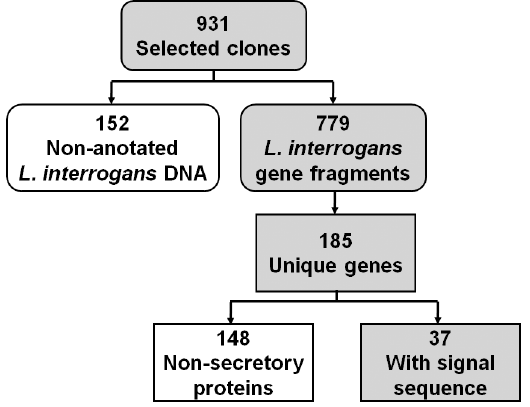
Figure 1. Schematic of analysis of phage clones that bind to endothelial EA.hy926 monolayers. Following three rounds of selection for phage clones that bind endothelial cells, 931 clones were sequenced and analyzed by BLAST. Seven hundred seventy-nine phage clones have DNA inserts of L. interrogans open reading frames, corresponding to 185 unique genes. Using prediction programs SignalP 3.0 and LipoP 1.0, 37 of the 185 identified genes contain signal peptide at the N-terminus of the predicted protein